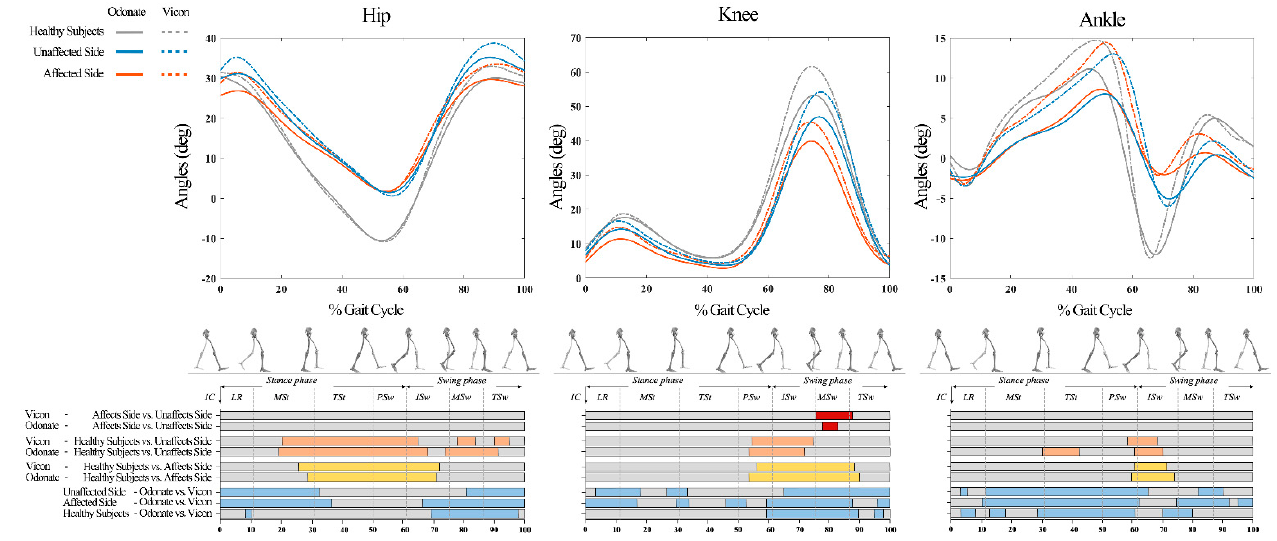
Figure 5. The lower limb kinematic curves measured by two systems for all participants. Significant differences between waveforms are indicated by the color bars under each graph. Blue color bars denote Odonate vs. Vicon on the Healthy Subjects, Affected Side, and Unaffected Side. Yellow, orange, and red color bars indicate the SPM independent − sample t − test results of each system for Healthy Subjects, Affected Side, and Unaffected Side, respectively. Table 2. CMC results of the Odonate system in lower limb kinematics.